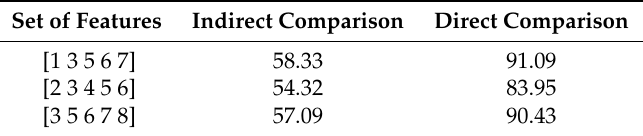
Table 3. Results of the second round of measurements four months after the initial ones. Data for Gyroscope Y.